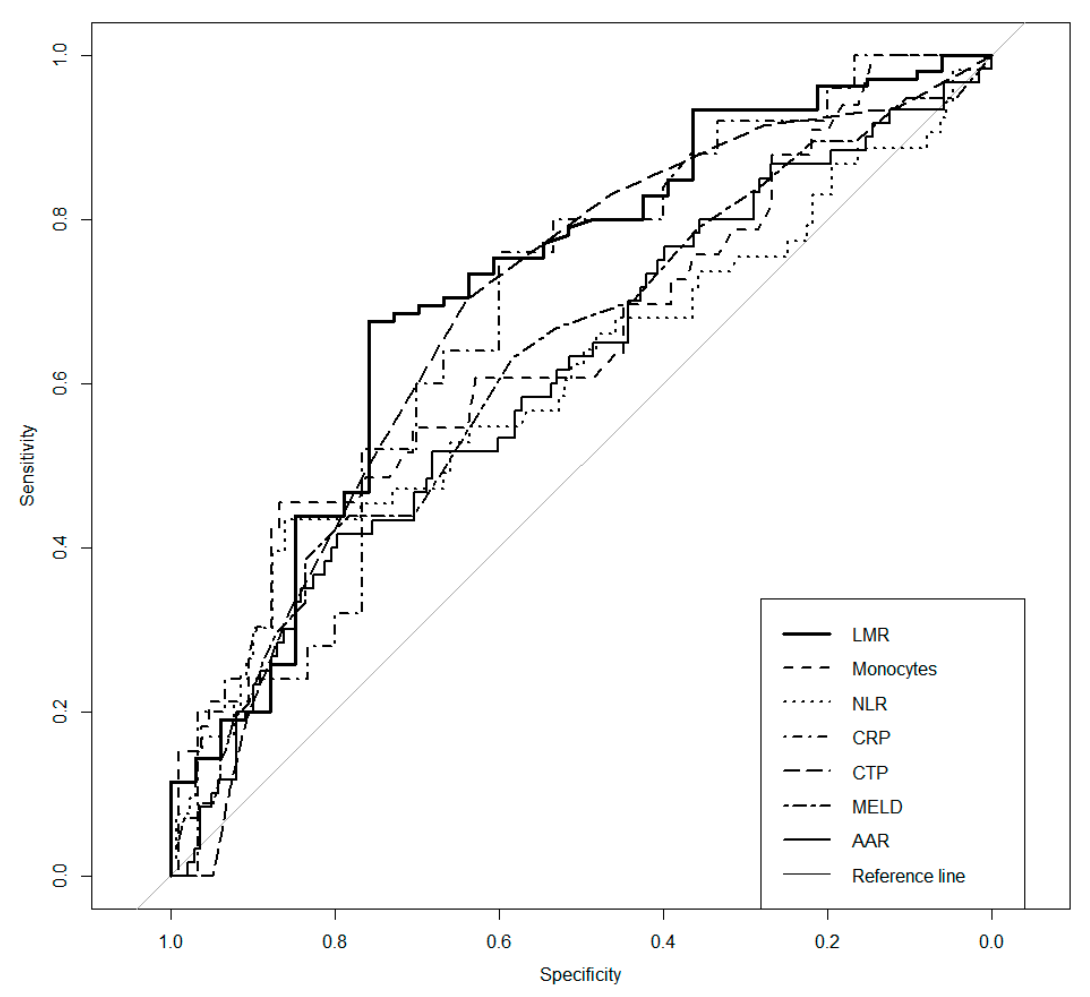
Figure 1. Receiver operating characteristics (ROC) curves. NLR—neutrophil-to-lymphocyte ratio; LMR—lymphocyte-to-monocyte ratio; AAR—aspartate aminotransferase-to-alanine aminotransferase ratio; CRP—C-reactive protein; CTP—Child-Turcotte-Pugh; MELD—Model for End-Stage Liver Disease. Table 4. Area under the curve (AUC), cuto ff values, Se, Sp, positive predictive value (PPV), and negative predictive value (NPV) for statistically significant